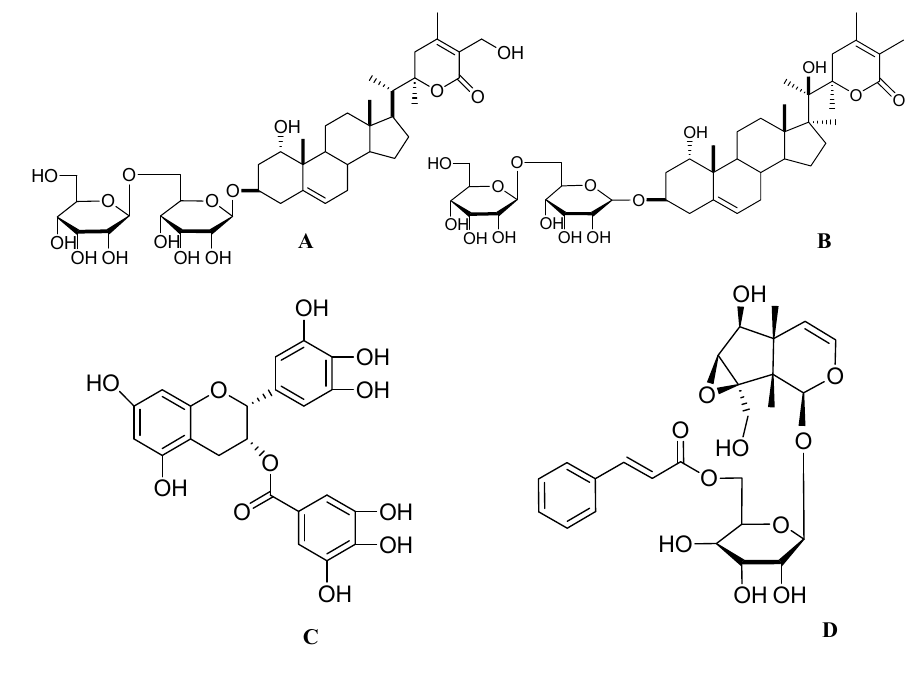
Figure 2. The molecular structures of withanoside IV ( A ), withanoside VI ( B ), epigallocatechin-3-gallate ( C ) and picroside I ( D